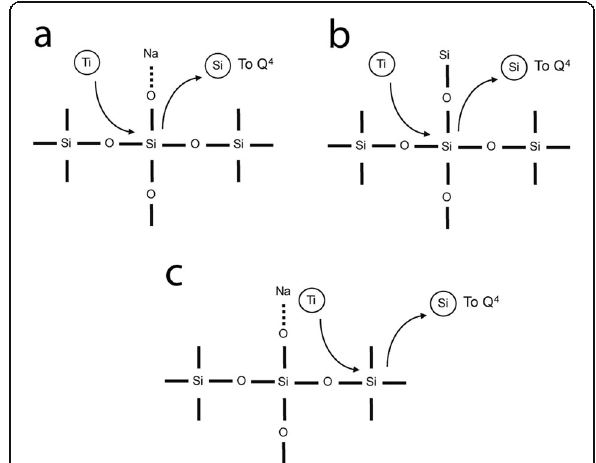
Fig. 7 Three different mechanisms by which [4] Ti can be incorporated into the glass structure include: a in replacement of Q 3 Si, which would induce a loss of Q 3 Si and growth of Q 4 Si in the NMR spectra, which is not observed, b for Q4 Si in the network with no adjacent Q3 Si, which would incite the growth of an additional Q4 peak at a slightly higher energy than the primary Q4 peak, and c for Q4 Si adjacent to Q3 Si, which would incite a peak shift toward higher frequency of the Q3 Si peak. The latter is not observed in the NS8 glasses, but a slight shift in peak position is detectable in the NS4 glasses (Fig.